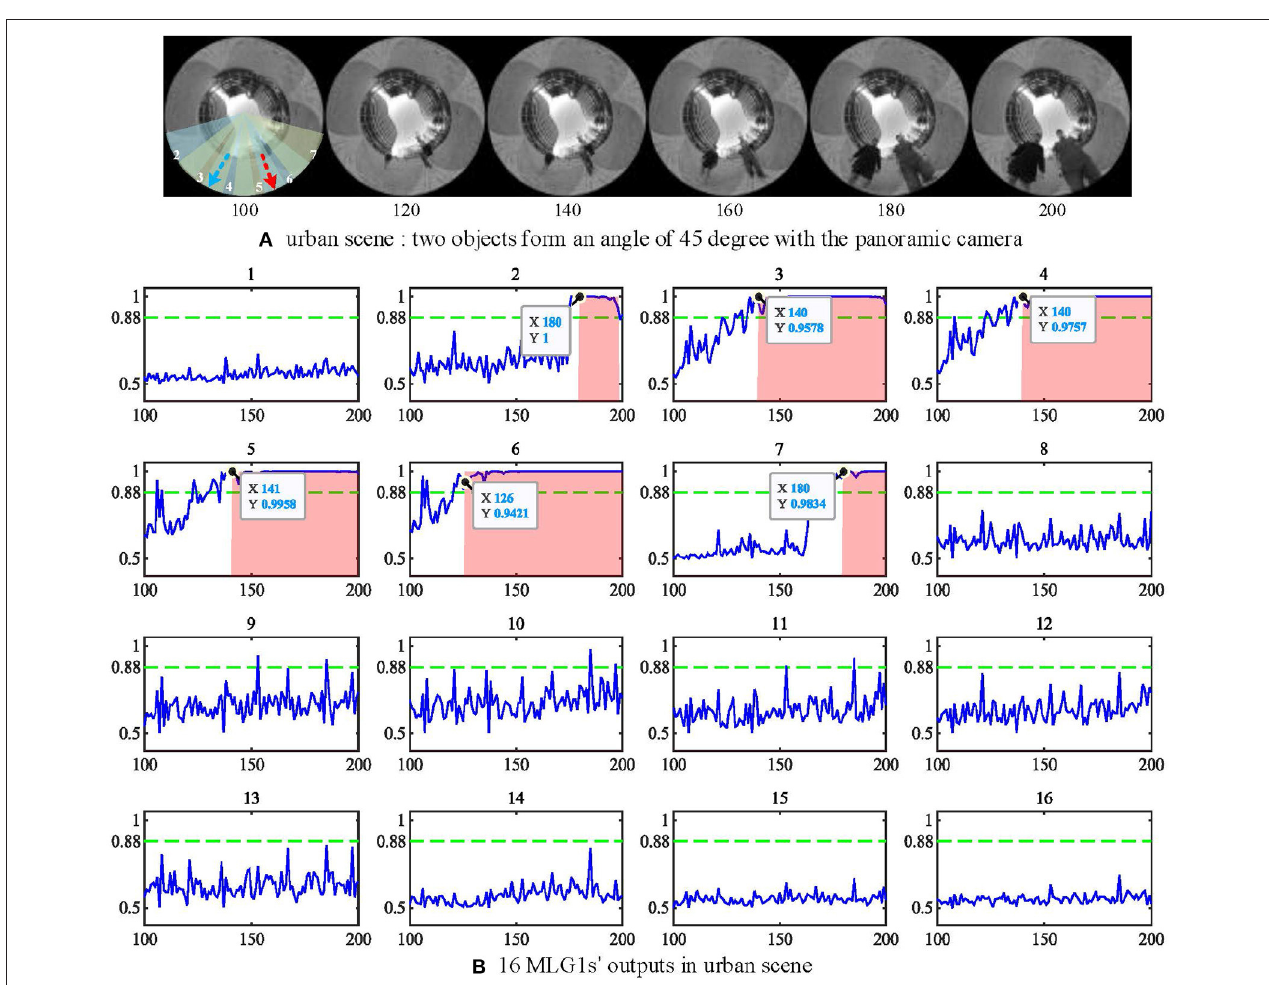
FIGURE 13 | (A) urban scene. Two approaching people form an angle of 45 deg with the camera. The red and blue dashed lines represent the two approaching trajectories. (B) the outputs of 16 MLG1s in urban scene. The person at segment 6 (red line) approaches a little faster, so the neuron response first exceeds the threshold at frame 120, and the first collision warning is generated at frame 126. The Y-axis denotes a normalized membrane potential and the X-axis denotes the number of